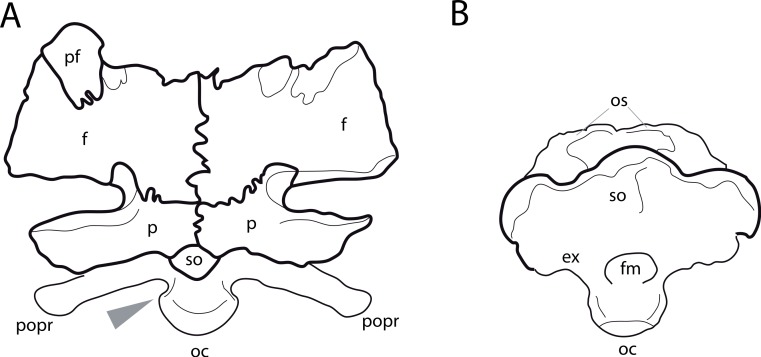
Neosauropod braincases.Braincase of Camarasaurus sp. UUVP 4286 (A; modified from Madsen, McIntosh & Berman, 1995) and Tornieria africana MB.R.2386 (B) in a view perpendicular to the dorsal surface of the occipital condyle, illustrating the distinctly offset articular surface (arrow in A; C77-0), in contrast to the derived condition of diplodocoids (B; C77-1). Abb.: ex, exoccipital; f, frontal; fm, foramen magnum; oc, occipital condyle; os, orbitosphenoid; p, parietal; pf, prefrontal; popr, paroccipital process. Skulls scaled to same breadth of occipital condyle.